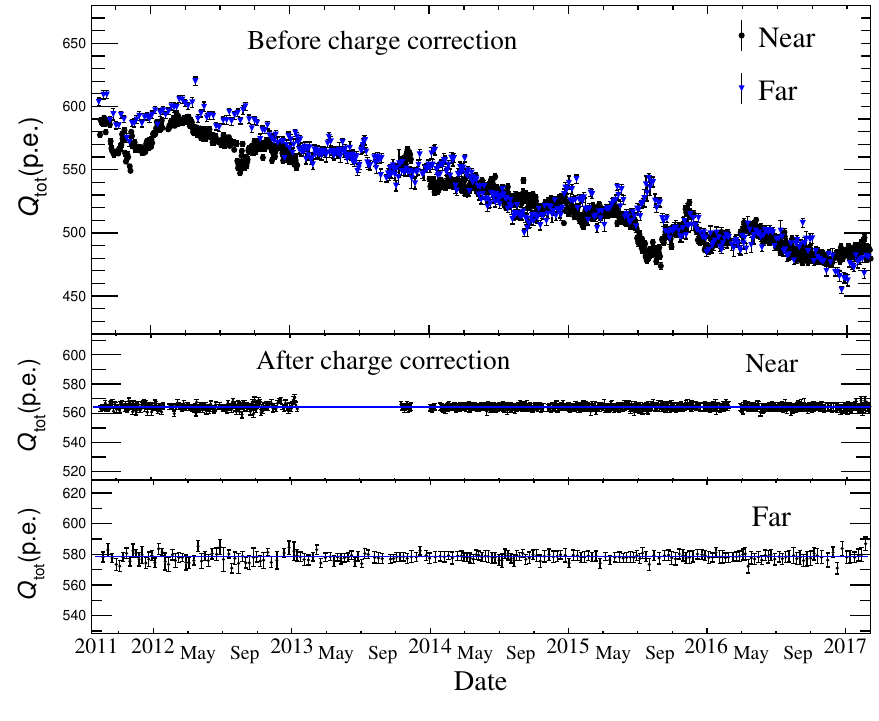
Figure 4 . Raw charge variation (top panel) and corrected charge stability (bottom panel) of n-H delayed signal in the GC. The raw Q tot decreases over time and the corrected one becomes close to the reference value in the initial period. Roughly 400 days of near detector data are unused for this analysis because of an electrical noise coming from an uninterruptible power supply (UPS).